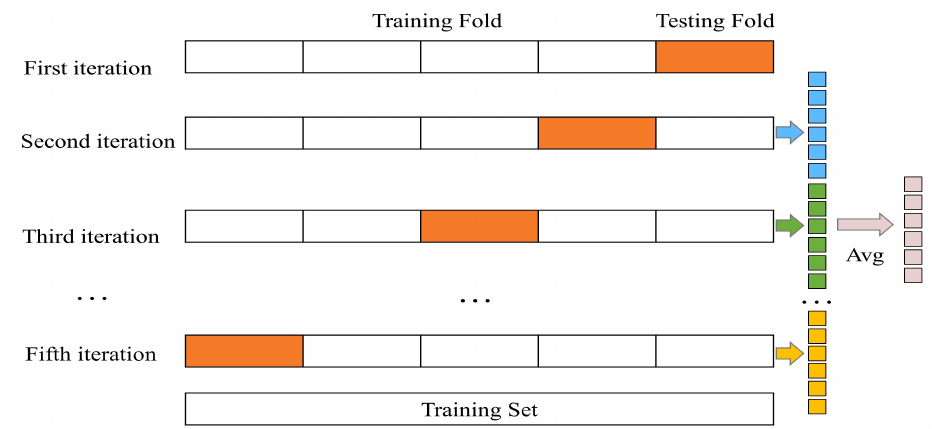
Figure 4. Augmented features generation of each classifier. K-fold cross validation is used for each classifier to generate K-1 estimated class vectors, which are averaged to obtain a final vector as augmented